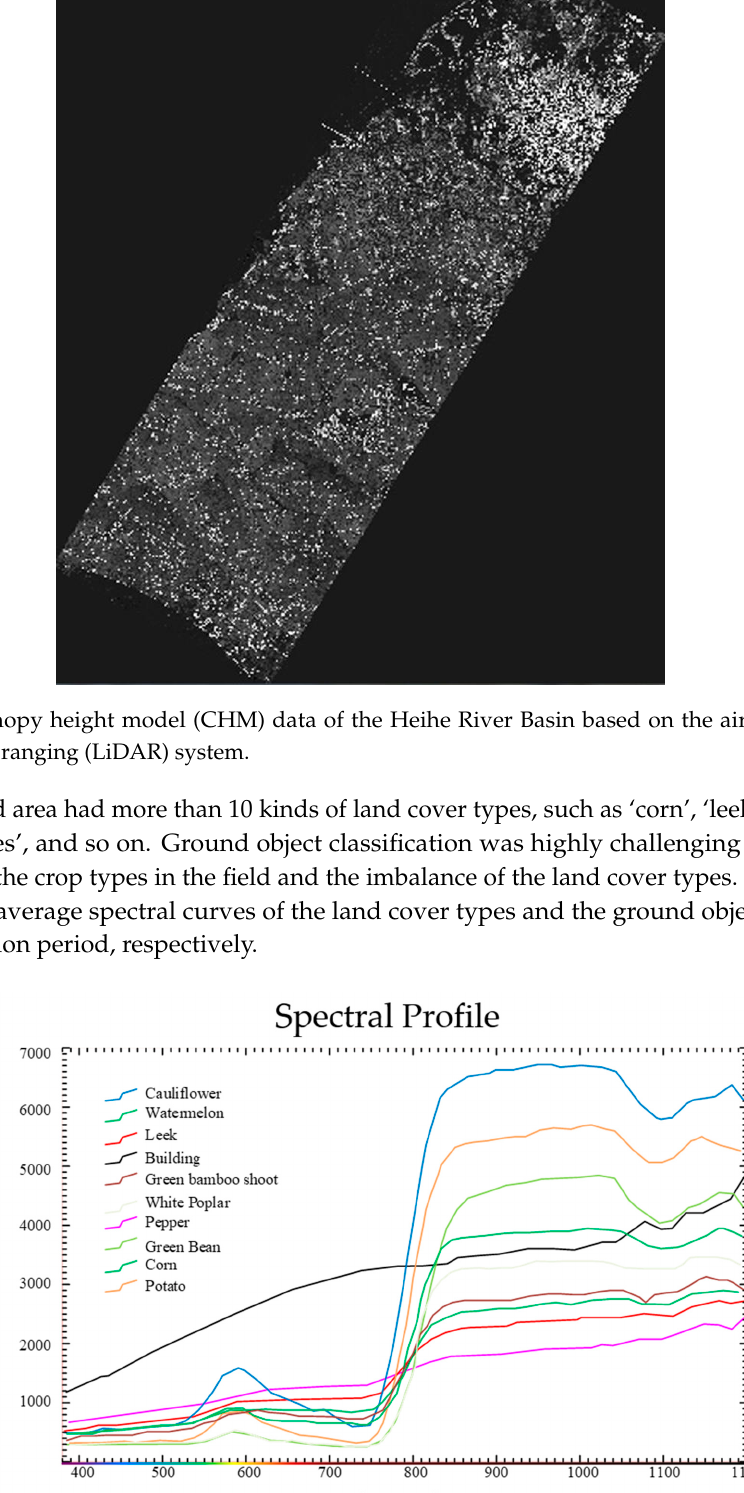
Figure 3. Average spectral curves for different land cover types in the data collection period.